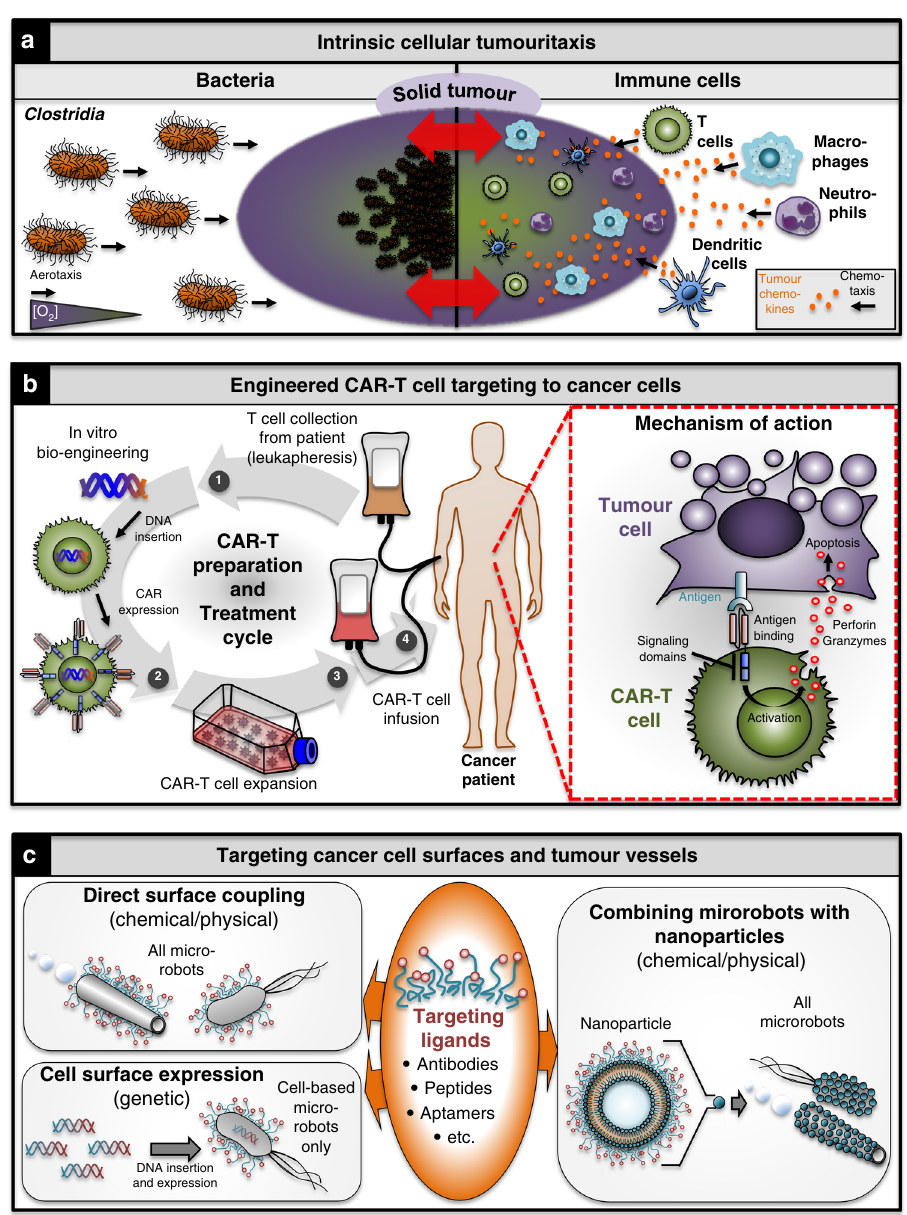
Fig. 5 Microrobot approaches for overcoming short-range tumour-targeting challenges. a Intrinsic tumouritaxis exhibited by some bacteria, such as Clostridia , and higher eukaryotic immune cells. b FDA-approved pipeline for engineering CAR-T cells as a personalised cancer medicine (left). CAR-T cells target cancer cells by recognising tumour antigens on their surface that induce downstream TCR signalling, including cytotoxic perforin and granzyme reactions. c Targeting tumours via speci fi c surface markers on the cells themselves, or on the vessels that supply the tumour. Using chemical/physical engineering methods, targeting moieties can be coupled directly to the microrobot surfaces or as part of non-motile nanoparticles, as illustrated